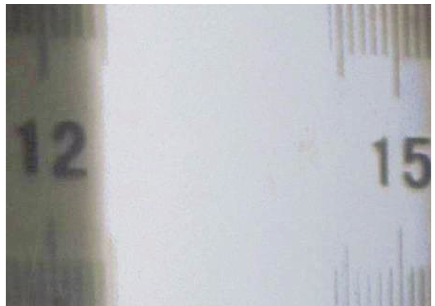
Figure 10: The width of focal line for parabolic trough solar concentrator.